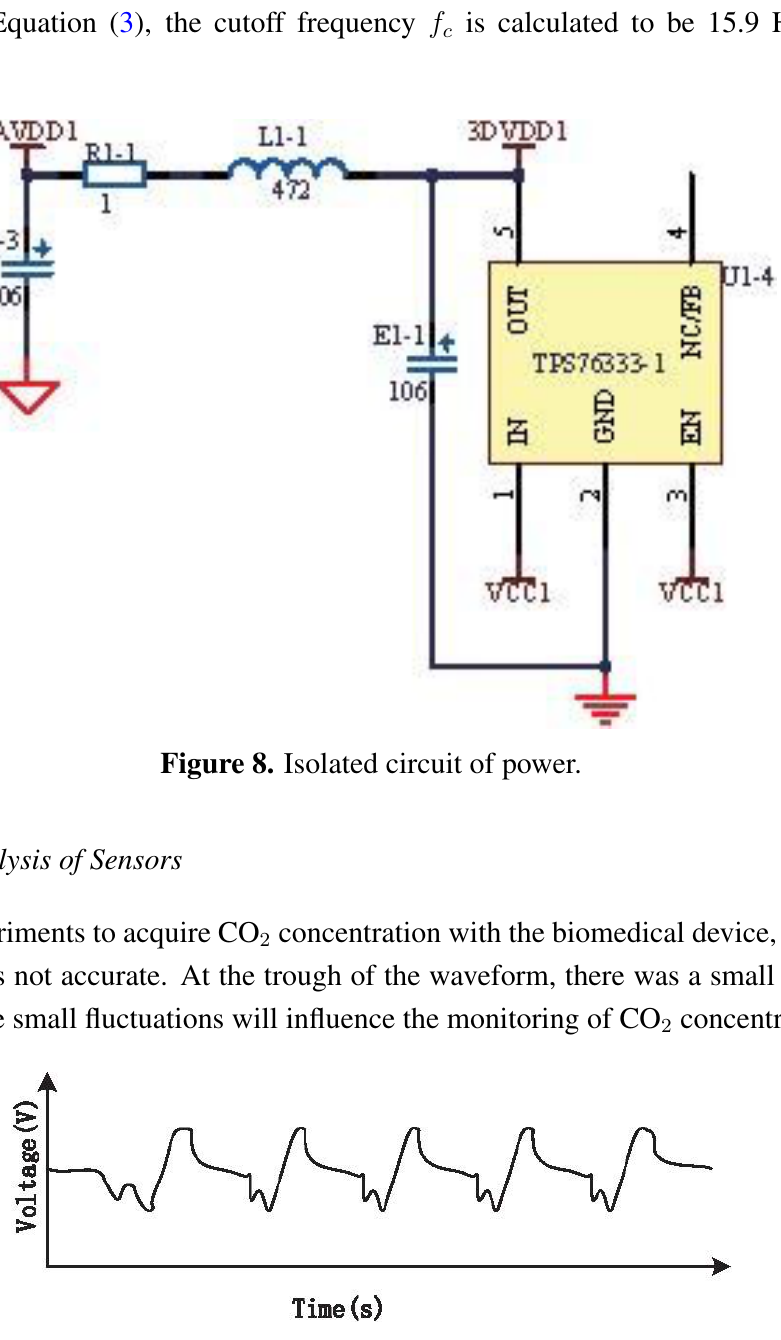
Figure 9. CO sensor signal before eliminating 2